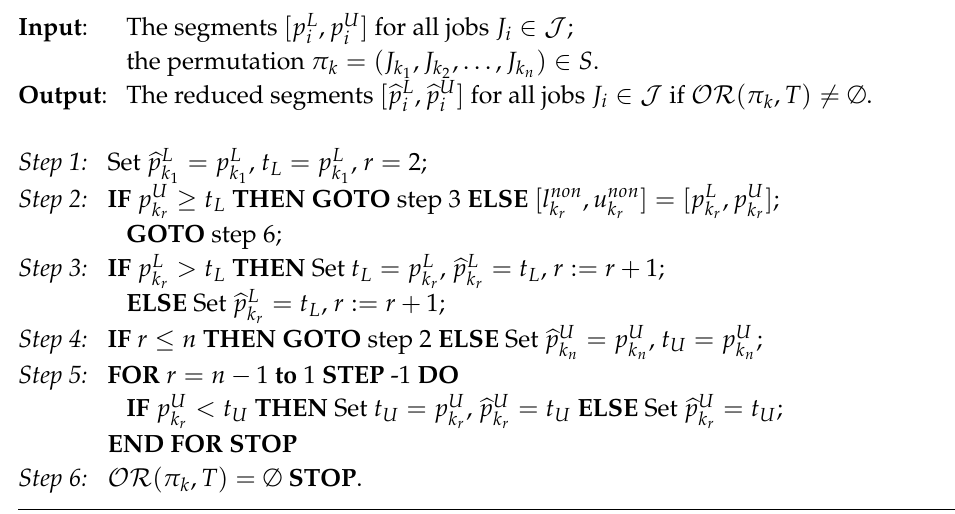
Algorithm 1: Construction of the instance with the reduced segments of possible